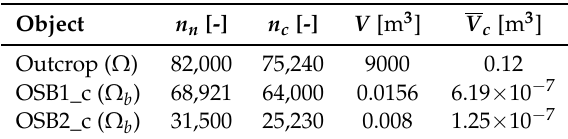
Table 1. Statistical characteristics of the outcrop mesh and both cube meshes ( n n = number of nodes, n c = number of cells, V = volume of the mesh, V c = average volume of a mesh cell). Object n n